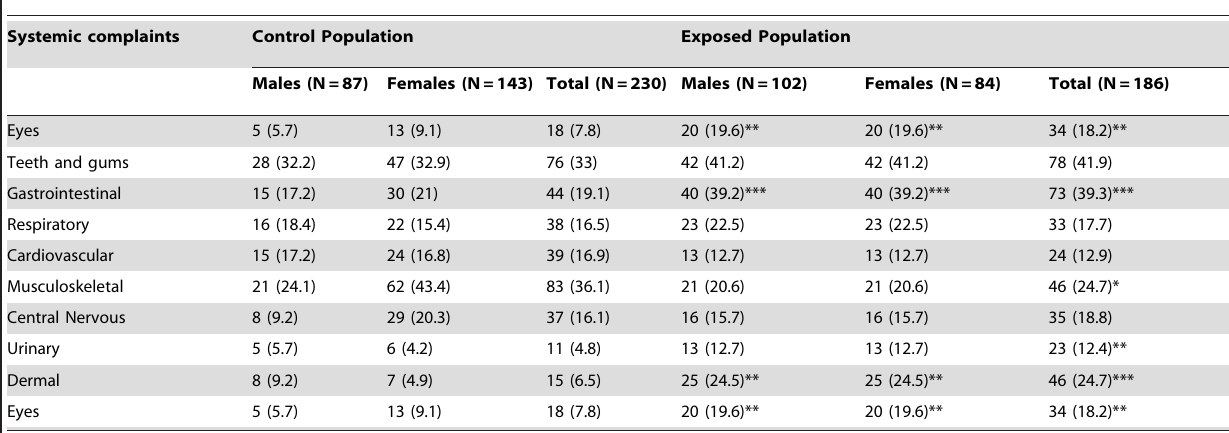
Table 2. Prevalence of systemic health complaints among exposed population compared with controls.